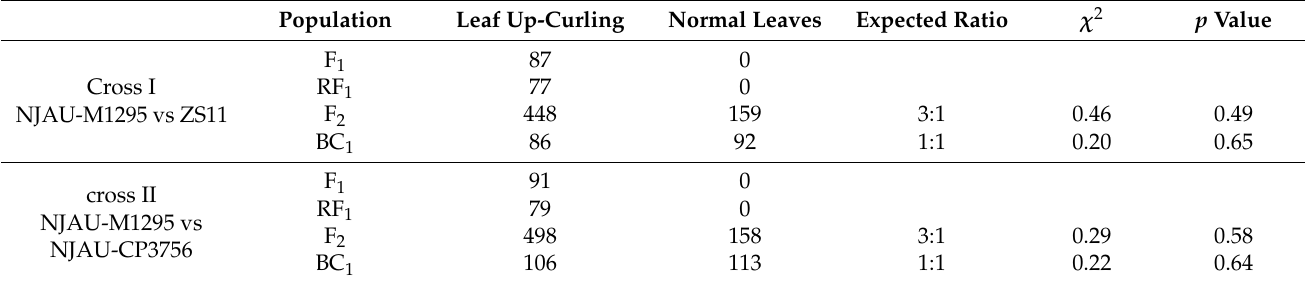
Table 3. Inheritance of BnUC3 in populations derived from NJAU-M1295 vs. ZS11 and NJAU-CP3756 in B. napus. Population Leaf Up-Curling Normal Leaves Expected Ratio